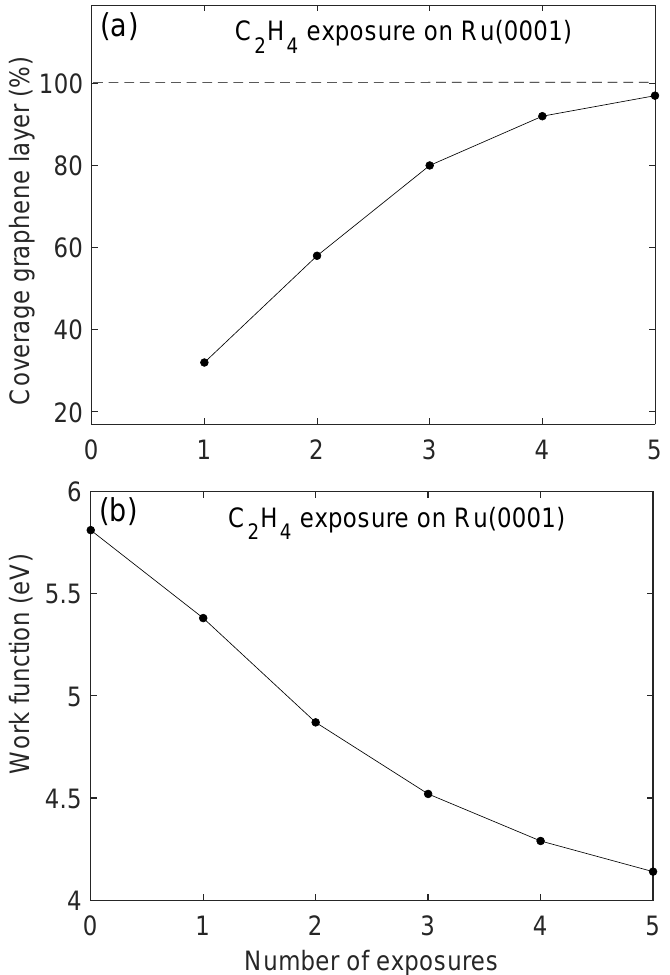
Figure 3. ( a ): Estimated graphene coverage (in % of saturation coverage which is assumed to be one monolayer), and ( b ): Sample work function from UPS data, for increasing number of exposure and annealing cycles of C 2 H 4 on